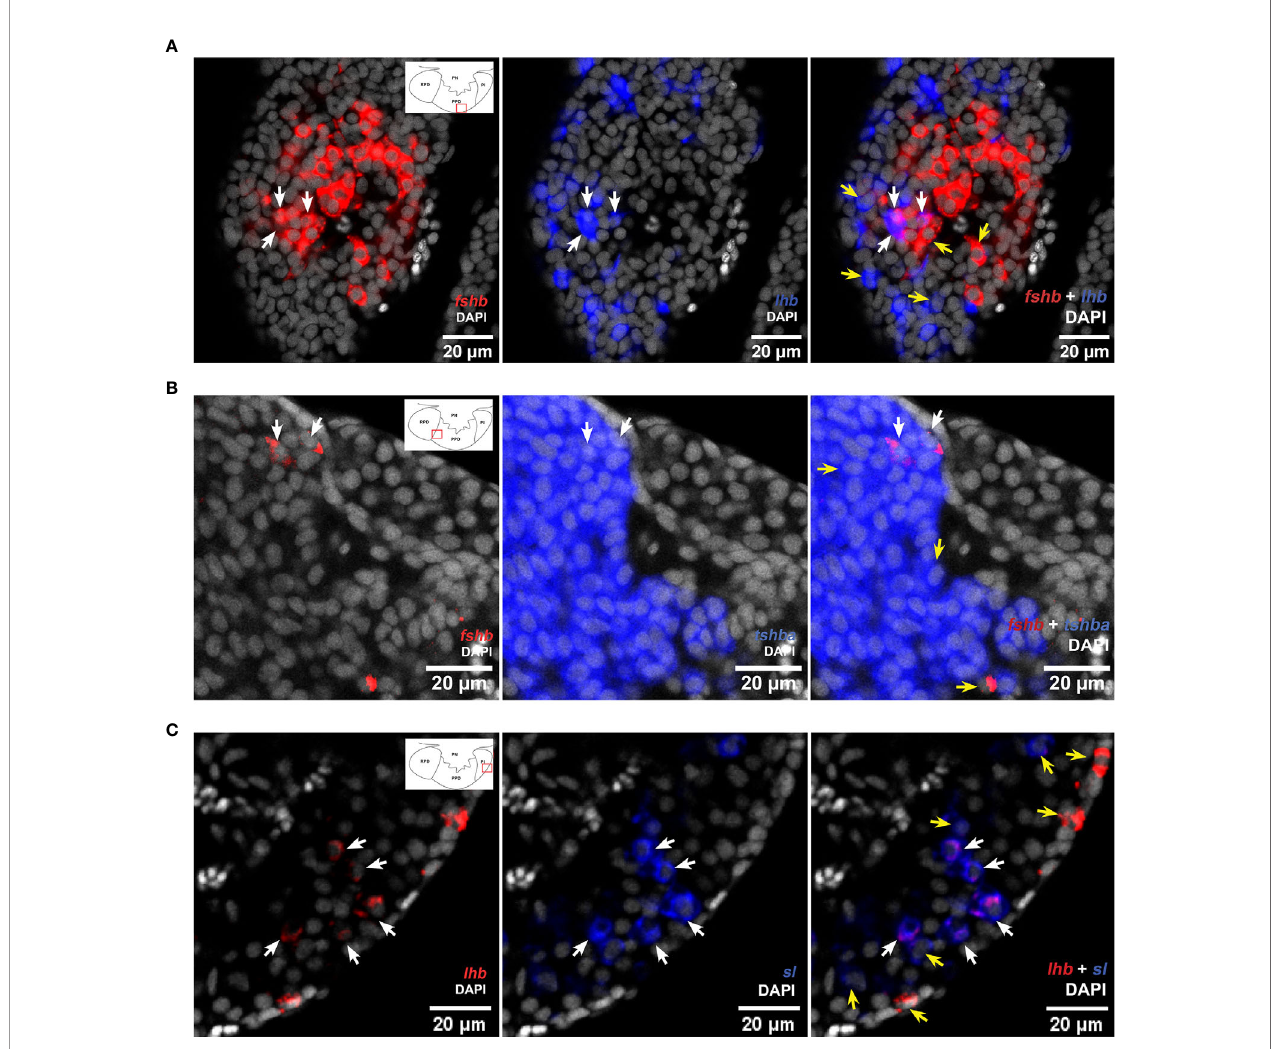
FIGURE 6 | Multi-color FISH reveals some cells co-expressing more than one hormone-encoding genes in the medaka pituitary. Single confocal planes (pinhole aperture 1 Airy Unit (0.8 -1.1 µm section)) con fi rming colocalization of lhb and fshb (A) , and fshb and tshb (B) in both male and female, and lhb and sl in the adult male medaka pituitary (C) . White arrows show cells with co-expressed mRNAs, while yellow arrows show cells without (can be used as control of probe´s speci fi city). The location of the bi-hormonal cells is in the proximity of the red rectangles as illustrated in the schematic drawings of the pituitaries in left